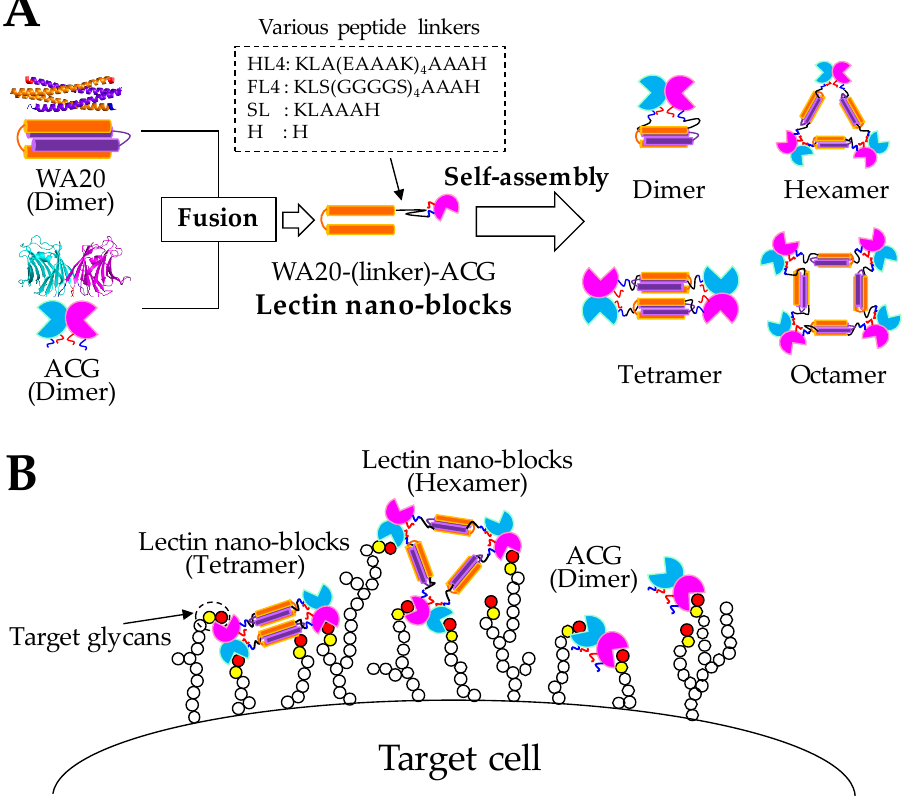
Figure 1. Schematics of the lectin nano-blocks. ( A ) Design of the lectin nano-blocks. The lectin nano-blocks were constructed by fusing the dimeric de novo protein WA20 (PDB ID: 3VJF) [9] to the dimeric lectin Agrocybe cylindracea galectin (ACG) (PDB ID: 1WW7) [30] with different type of linkers (HL4, FL4, SL, and H). In addition, WA20- ΔN3ACG was constructed by fusing WA20 and ACG without a linker and with the deletion of the N-terminal 3 aa of ACG. Since both WA20 and ACG form dimer, the lectin nano-blocks are expected to form self-assembling oligomers in multiples of 2-mer. ( B ) Schematics of the binding of the lectin nano-blocks and ACG to target glycans on cells. Because the lectin nano-block oligomers have more carbohydrate recognition domains (CRDs) than the original ACG, they are expected to enhance the binding avidity to target glycans by multivalent binding